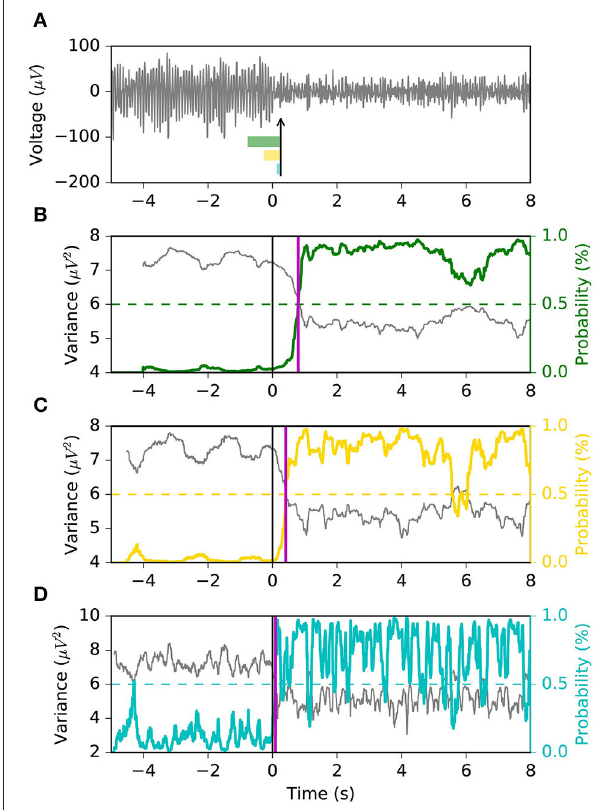
FIGURE 1 | Problem statement. The sliding window approach introduces a delay in the ERD detection. A long sliding window achieves a stable output (i.e., less false positives and more true positives) at the cost of a larger detection latency. A shorter sliding window is faster at detecting the ERD, but its output is less stable and has larger variability. Indeed, it is important to note that the left vertical axis of (D) covers a broader range. Panel (A) shows the EEG voltage obtained after optimal bandpass filtering and CSP spatial filtering (using the most discriminative CSP component) as described in section 2.4.3. The three rectangles represent the sliding window lengths (i.e., 1.0, 0.5, and 0.1 s) used for the models shown in (B–D) . The vertical arrow indicates the point in time corresponding to the output of the depicted sliding windows. Panels (B–D) represent the decoding associated with sliding window lengths 1.0, 0.5, and 0.1 s, respectively. Each shows the variance, computed on the signal in (A) by the respective sliding window, with a solid gray line. The probability output of the logistic regression classifier is drawn with a solid colored line. The vertical solid black line shows the time of the motor imagery cue onset. The horizontal dashed colored line shows the classifier’s threshold with respect to the classifier’s probability output (solid colored line). The vertical solid magenta line shows the estimated latency of detection. This example is taken from a subject performing left motor imagery.